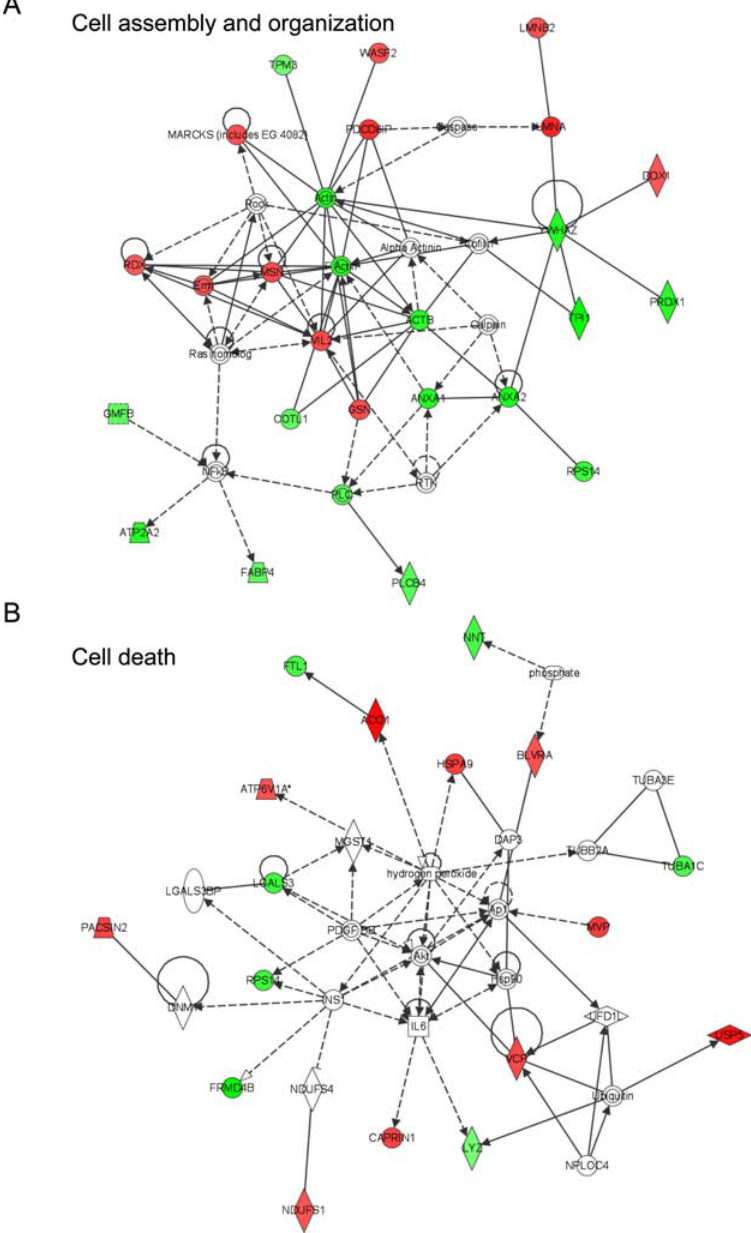
Figure 3. Ingenuity Pathway Analysis. Dynamic pathway/network modeling of the microglial proteome was afforded by integration of protein/ gene data to the Ingenuity Pathway Analysis software of Ingenuity H Systems. Generated pathways show significant correlations with cellular assembly and organization (A) and cell death (B) networks. Interactions between proteins are shown by lines, whereas the lines with arrows represent direct interactions and no-arrow lines indicate binding only. Solid lines show the direct interaction, while the broken lines show indirect interaction. Nodes are represented by shapes and colors. Functions are indicated by shapes: diamonds for enzymes, squares for cytokines, rectangles for ligand dependant nuclear factors, triangles for kinases, ovals for transcription regulators, trapezoids for transporters, and circles indicate other interactions. Red color nodes represent the microglial proteins which are up-regulated upon HIV-1/VSV infection, while the green color nodes represent down- regulated proteins. Nodes without color represent proteins not input by user, but interpreted by the database as highly probable interactions within the network. The abbreviation used are: ACO1, aconitase; ACTB, beta-actin; ANXA1, annexin A1; ANXA2, annexin A2; APC, adenomatous polyposis coli protein; ATP2A2, sarcoplasmic reticulum 2 + -Ca-ATPase; ATP6V1A, vacuolar ATP synthase catalytic subunit A; BLVRA, biliverdin reductase A; CAPRIN1, GPI-anchored protein p 137; COTL1, coactosin-like protein; DDX1, dead (Asp-Glu-Ala-Asp) box polypeptide 1; FABP4, fatty acid binding protein 4; FRMD4B, GRP1 binding protein; FTL1, ferritin light chain 1; GMFB, glia maturation factor beta; GSN, gelsolin; HSPA9, heat shock protein 70; LGALS3, galectin-3; LYZ, lysozyme; LMNA, lamin A; LMNB2, lamin B2; MARCKS (includes EG:4082), myristylated alanine-rich protein kinase C substrate; MAPRE1, microtubule-associated protein; MSN, moesin; PDCD6IP, programmed cell death 6-interacting protein; MVP, major vault protein; NDUFS1, NADH dehydrogenase (ubiquinone) Fe-S protein 1; NNT, nicotinamide nucleotide transhydrogenase; PACSIN2, protein kinase C and casein kinase substrate in neurons protein 2; PLCB4, phospholipase C beta 4; PRDX1, peroxiredoxin-1; RDX, radixin; RPS14, 40S ribosomal protein S14; TPI1, triosephosphate isomerase; TPM3, tropomyosin-3; TUBA1C, alpha-tubulin 6; USP5, ubiquitin carboxyl-terminal hydrolase 5; VCP, transitional endoplasmic reticulum ATPase; VIL2, cytovillin; WASF2, Wiskott-Aldrich syndrome protein family member 2; YWHAZ, tyrosine 3-monooxygenase/tryptophan 5- monooxygenase activation protein beta.